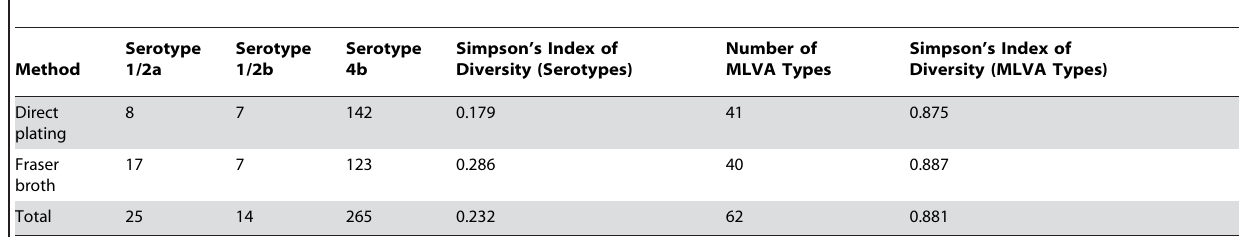
Table 4. Numbers of isolates of each serotype and the Diversity index for serotyping and for MLVA types in the samples based on the enrichment